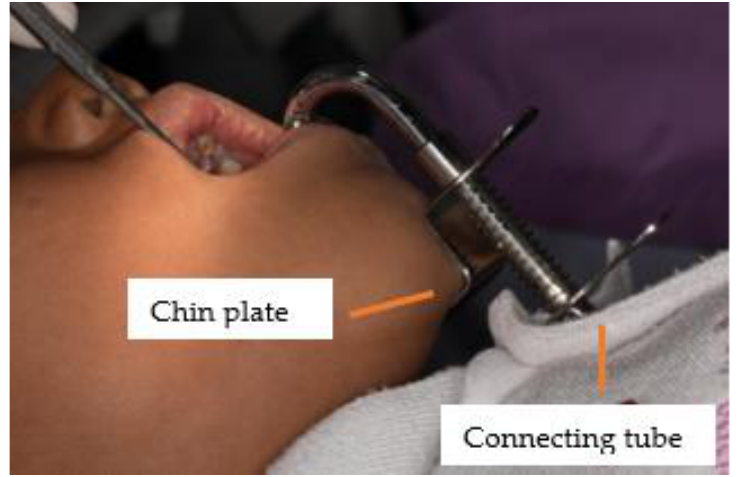
Figure 2. Extra - oral view of SS-suction in patients.